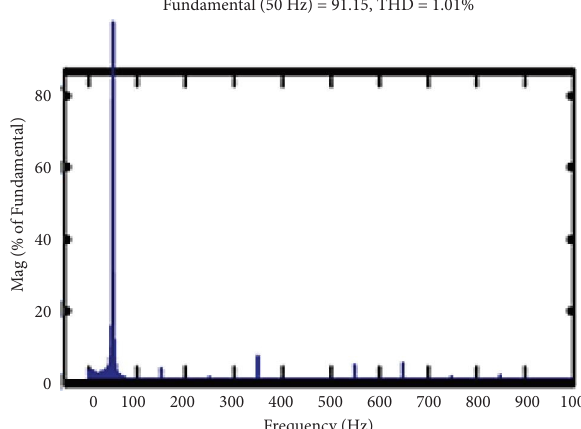
Figure 12: FFT analysis of current.